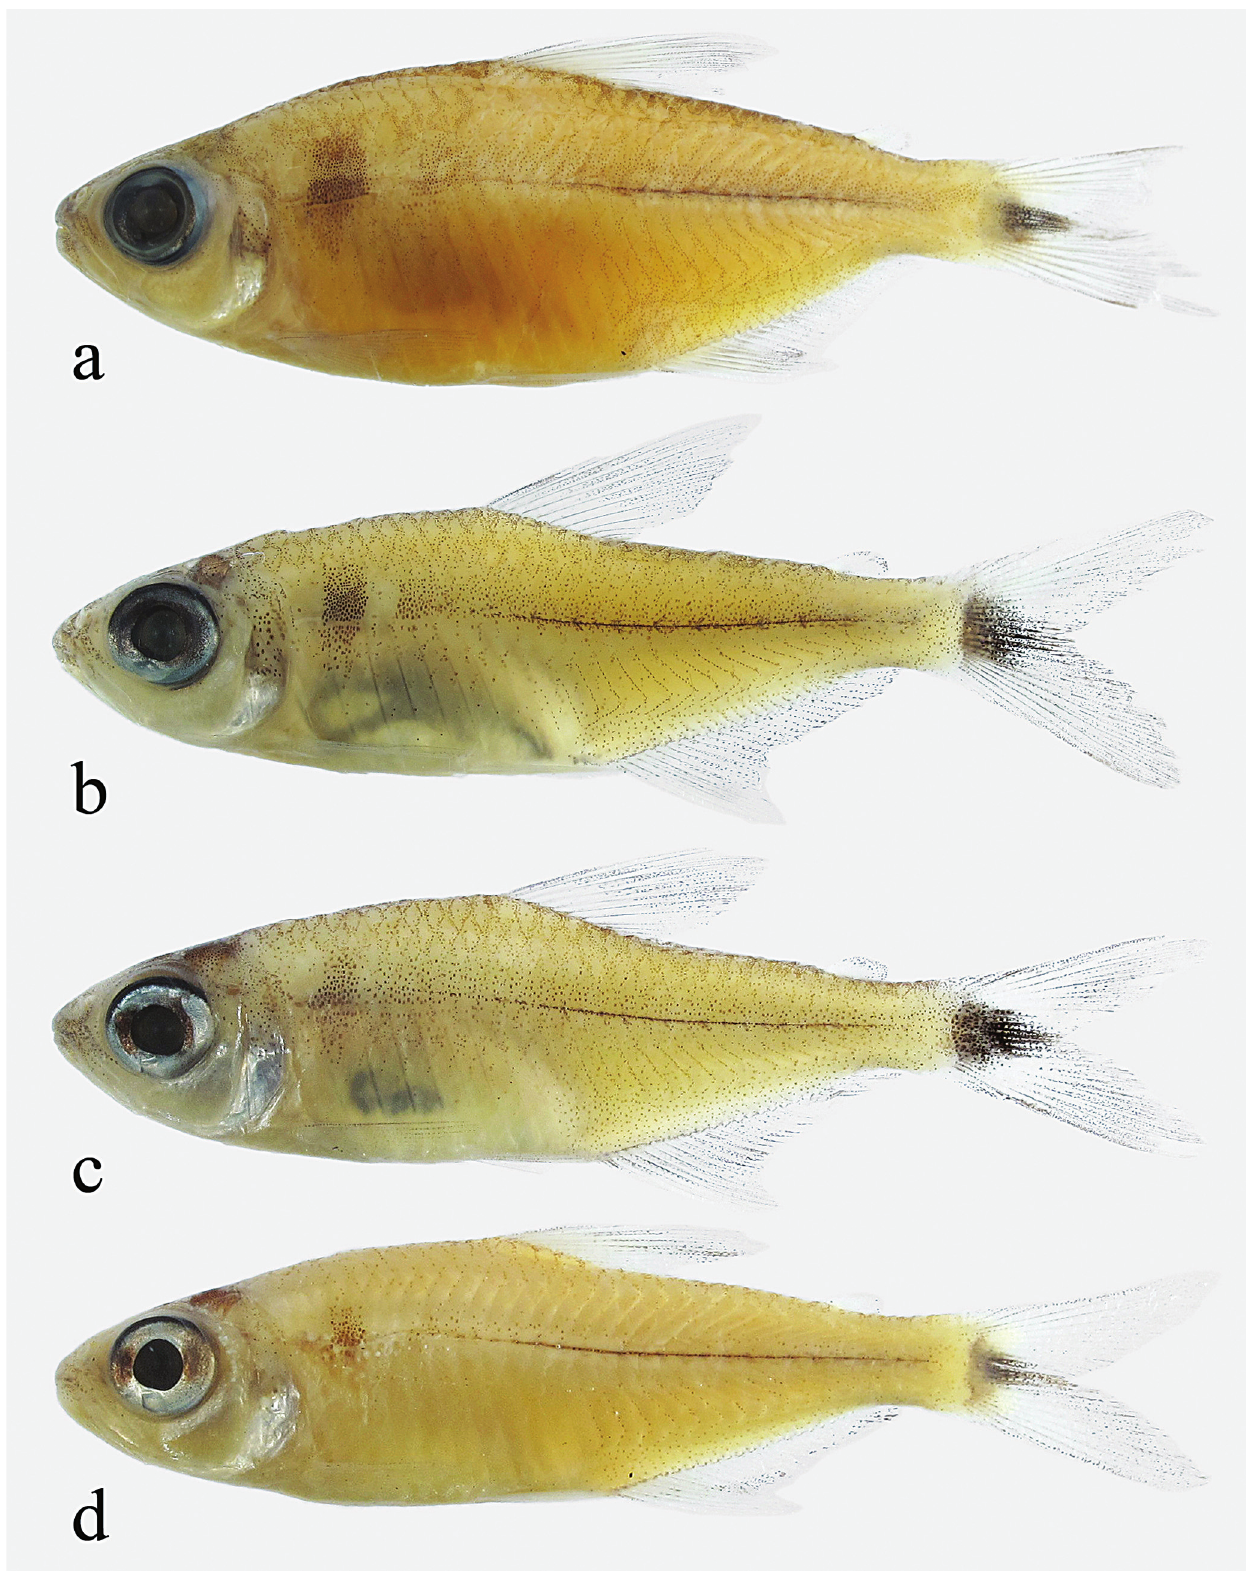
Fig. 2. Astyanax multidens : ( a ) MZUSP 96606, 44.6 mm SL, rio Peixoto de Azevedo, tributary of rio Teles Pires, ( b ) MZUSP 99818, 29.5 mm SL, rio Teles Pires, ( c ) MZUSP 94171, 25.7 mm SL, rio Culuene, tributary of rio Xingu, ( d ) MZUSP 52228, 25.2 mm SL, rio Água Fria, rio Araguaia